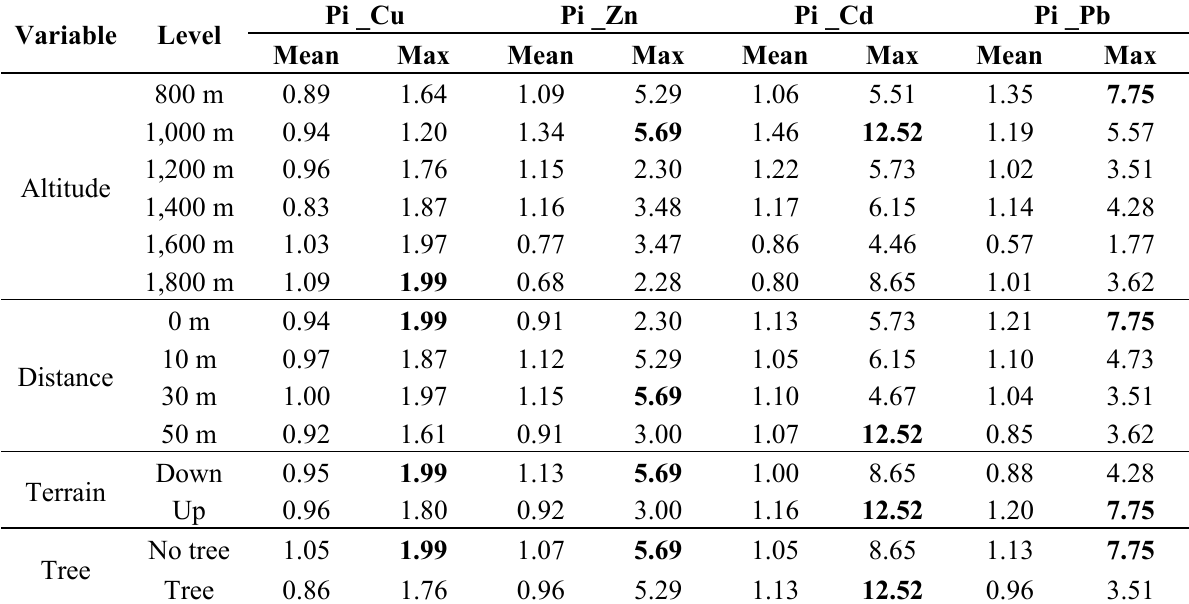
Table 4. Descriptive statistical results of heavy metal concentrations comparison between roadside samples and local background values.